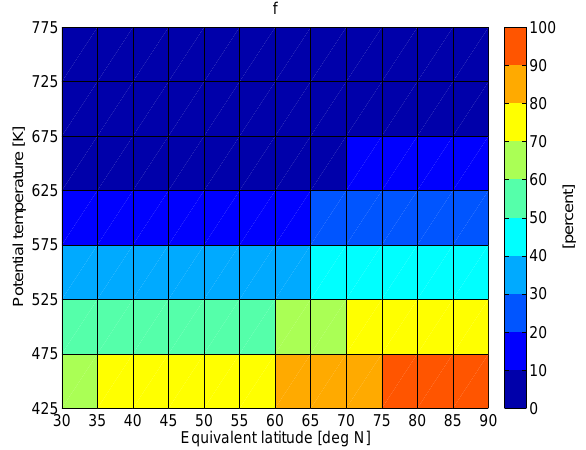
Fig. 5. Surviving fraction of an artificial ozone perturbation on 16 September 1999 as a function of equivalent latitude and potential temperature on 3 January